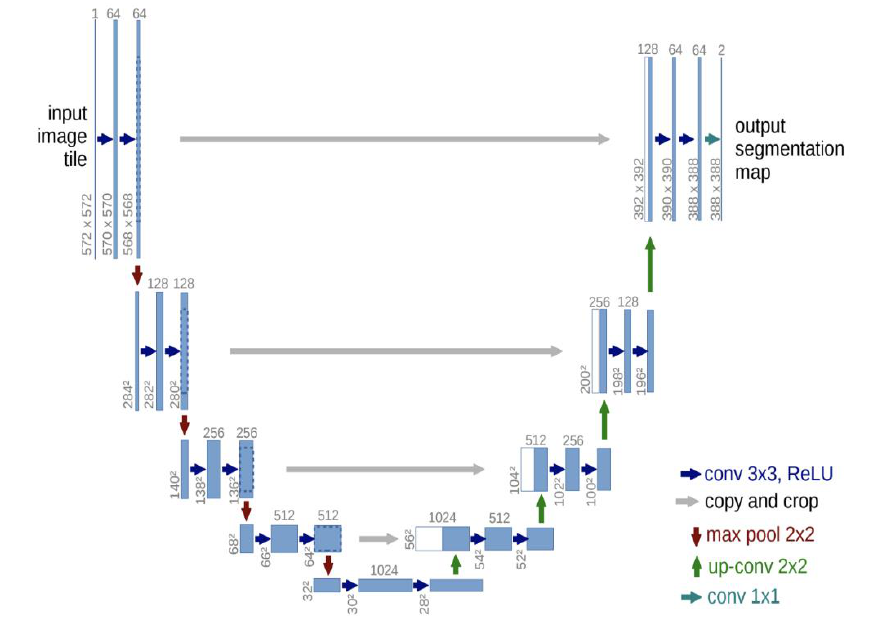
Figure A1. Structure of U-Net.